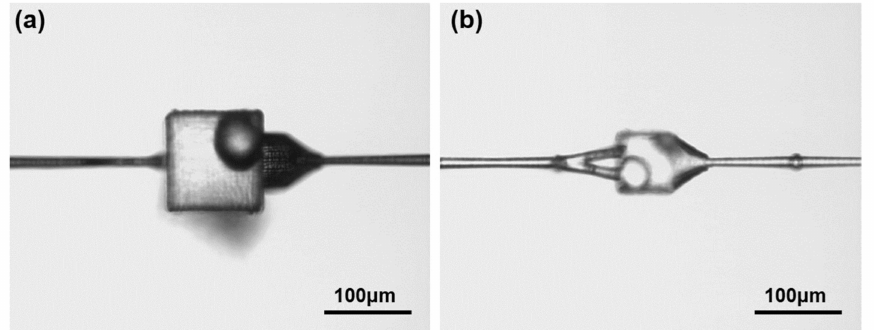
Figure 5. Microvalve device added with attachment structure. ( a ) a micro-cavity device composed of a cylinder and a cone; ( b ) a micro-cavity device composed of a conical structure and excessive